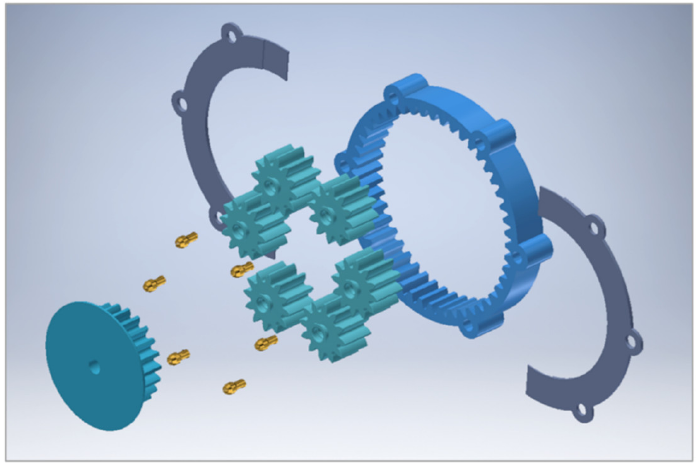
Figure 3. Virtual models with dimensional details of the 3D printed parts of the equipment.